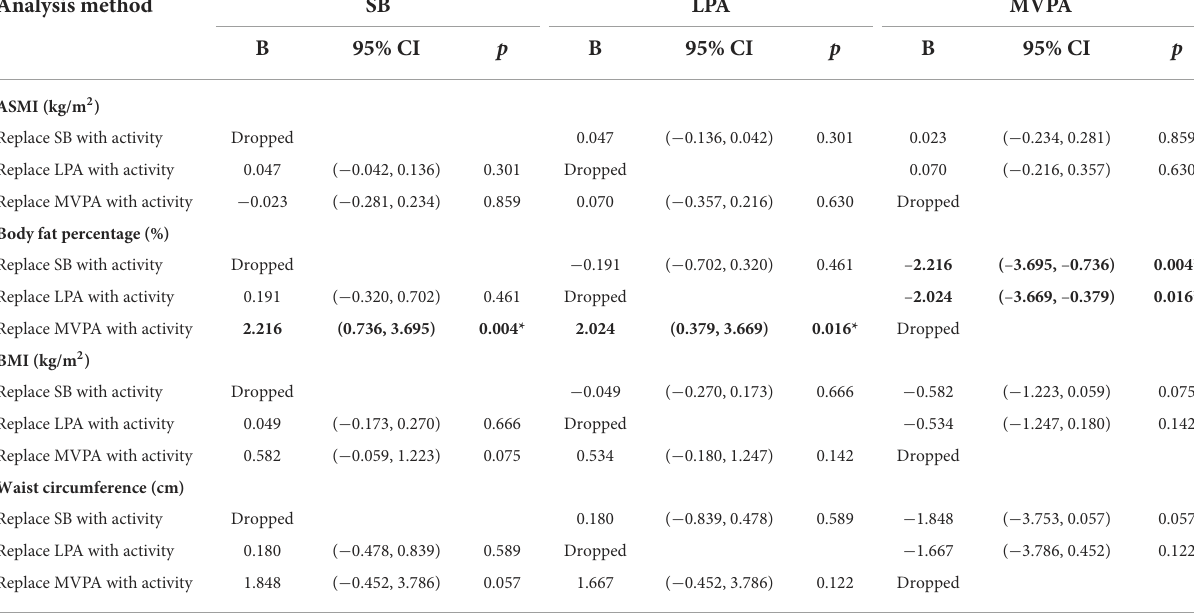
TABLE 2 Unadjusted isotemporal substitution models examining the associations of replacing 30min sedentary behavior, LPA, and MVPA on body composition ( n = 199). Analysis